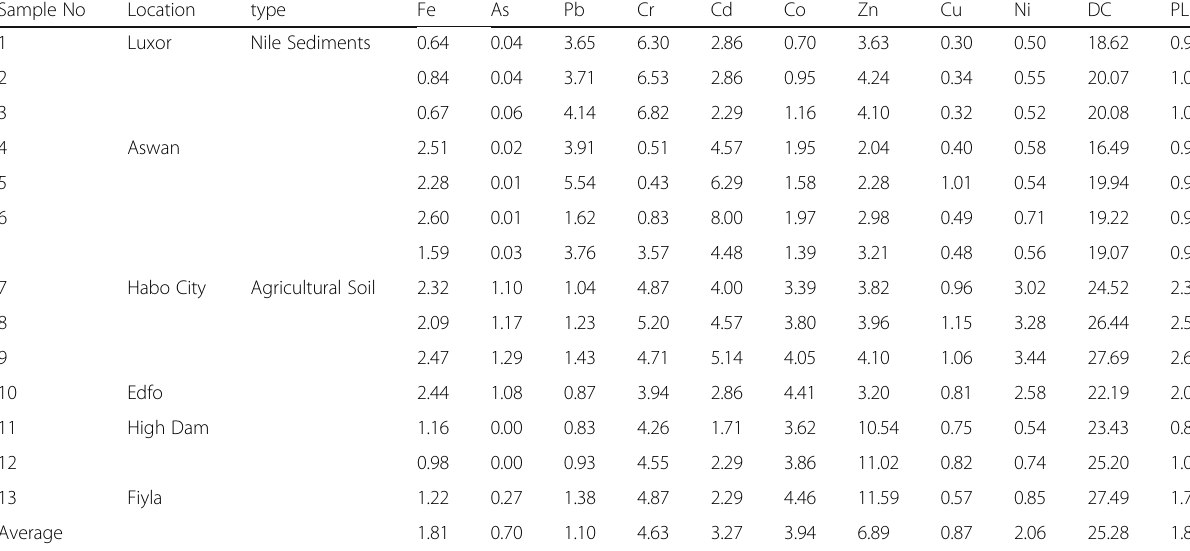
Table 3 Contamination factor, degree of contamination, and pollution load index pollution of the heavy metals of the study samples Sample